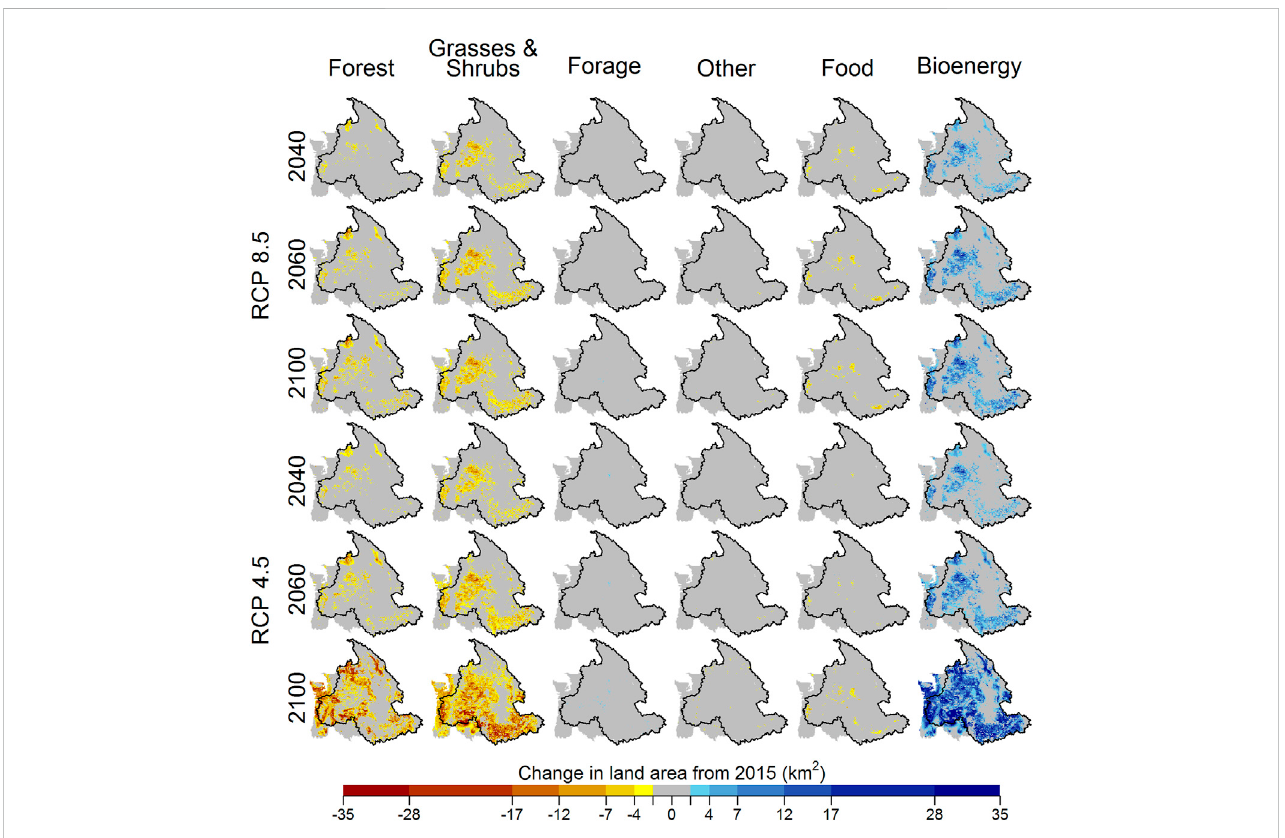
FIGURE 5 Spatially downscaled LULCC trends and six major land-use/cover categories under the RCP 8.5 and RCP 4.5 pathways. Trends are given in terms of difference from the 2015 base year. The grey area is the extended CRB, which includes land in western Washington and Oregon lying outside the CRB boundary. The black boundary demarcates the CRB